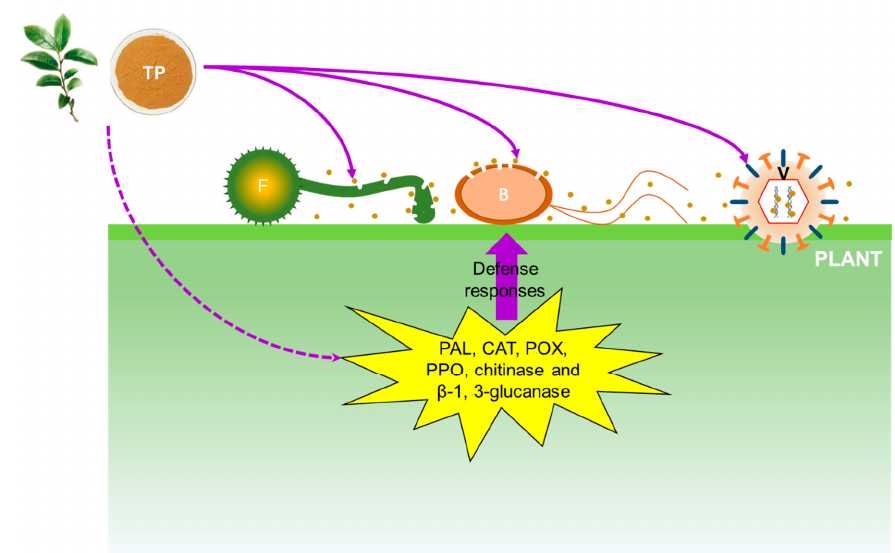
Figure 2. Schematic representation of the antimicrobial mechanisms of tea polyphenol. Brown dots represent tea polyphenol particles. TP: tea polyphenol; F: fungi; B: bacteria; V: virus; PAL: phenylalanine ammonia-lyase; CAT: catalase; POX: peroxidase; PPO: polyphenoloxidase.